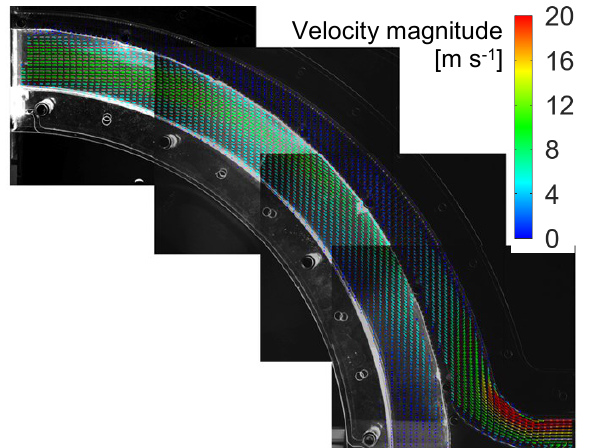
Fig. 4. Velocity vector field coloured by velocity magnitude for mean velocity of 7 m/s